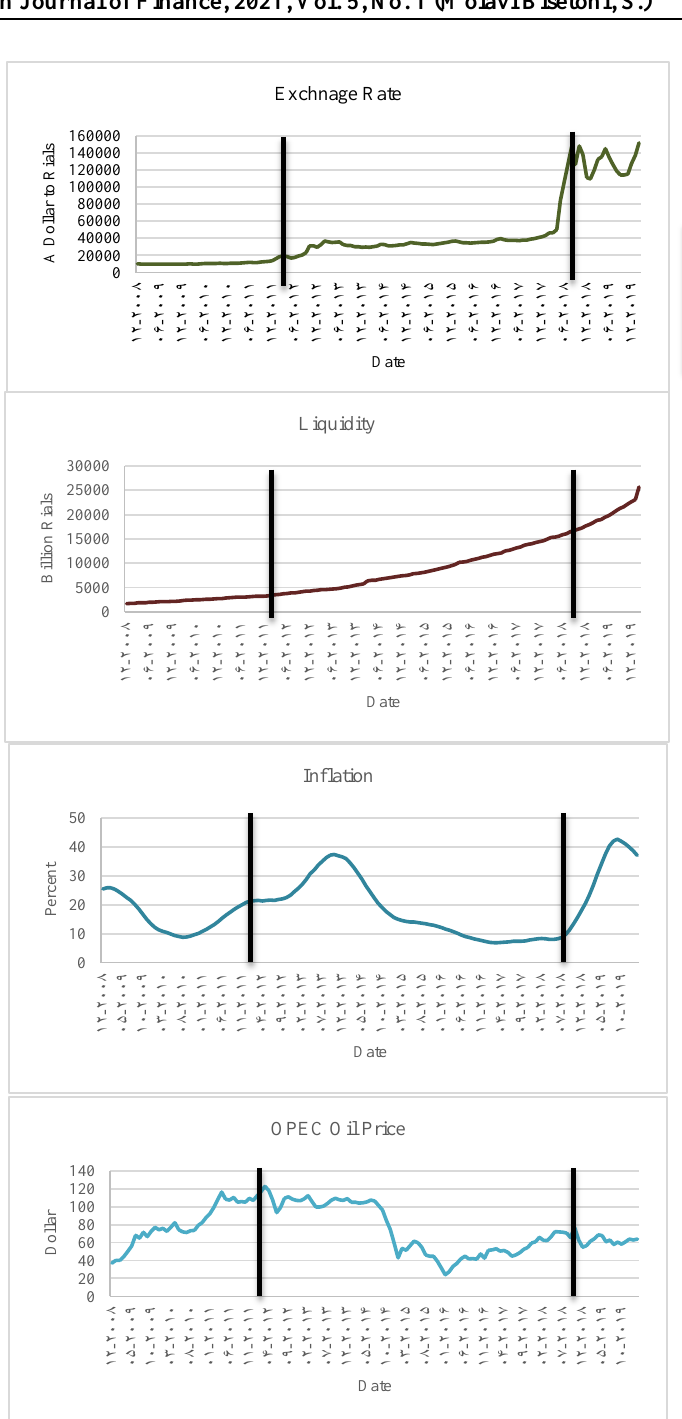
Figure 2. Time series data of the exogenous and control